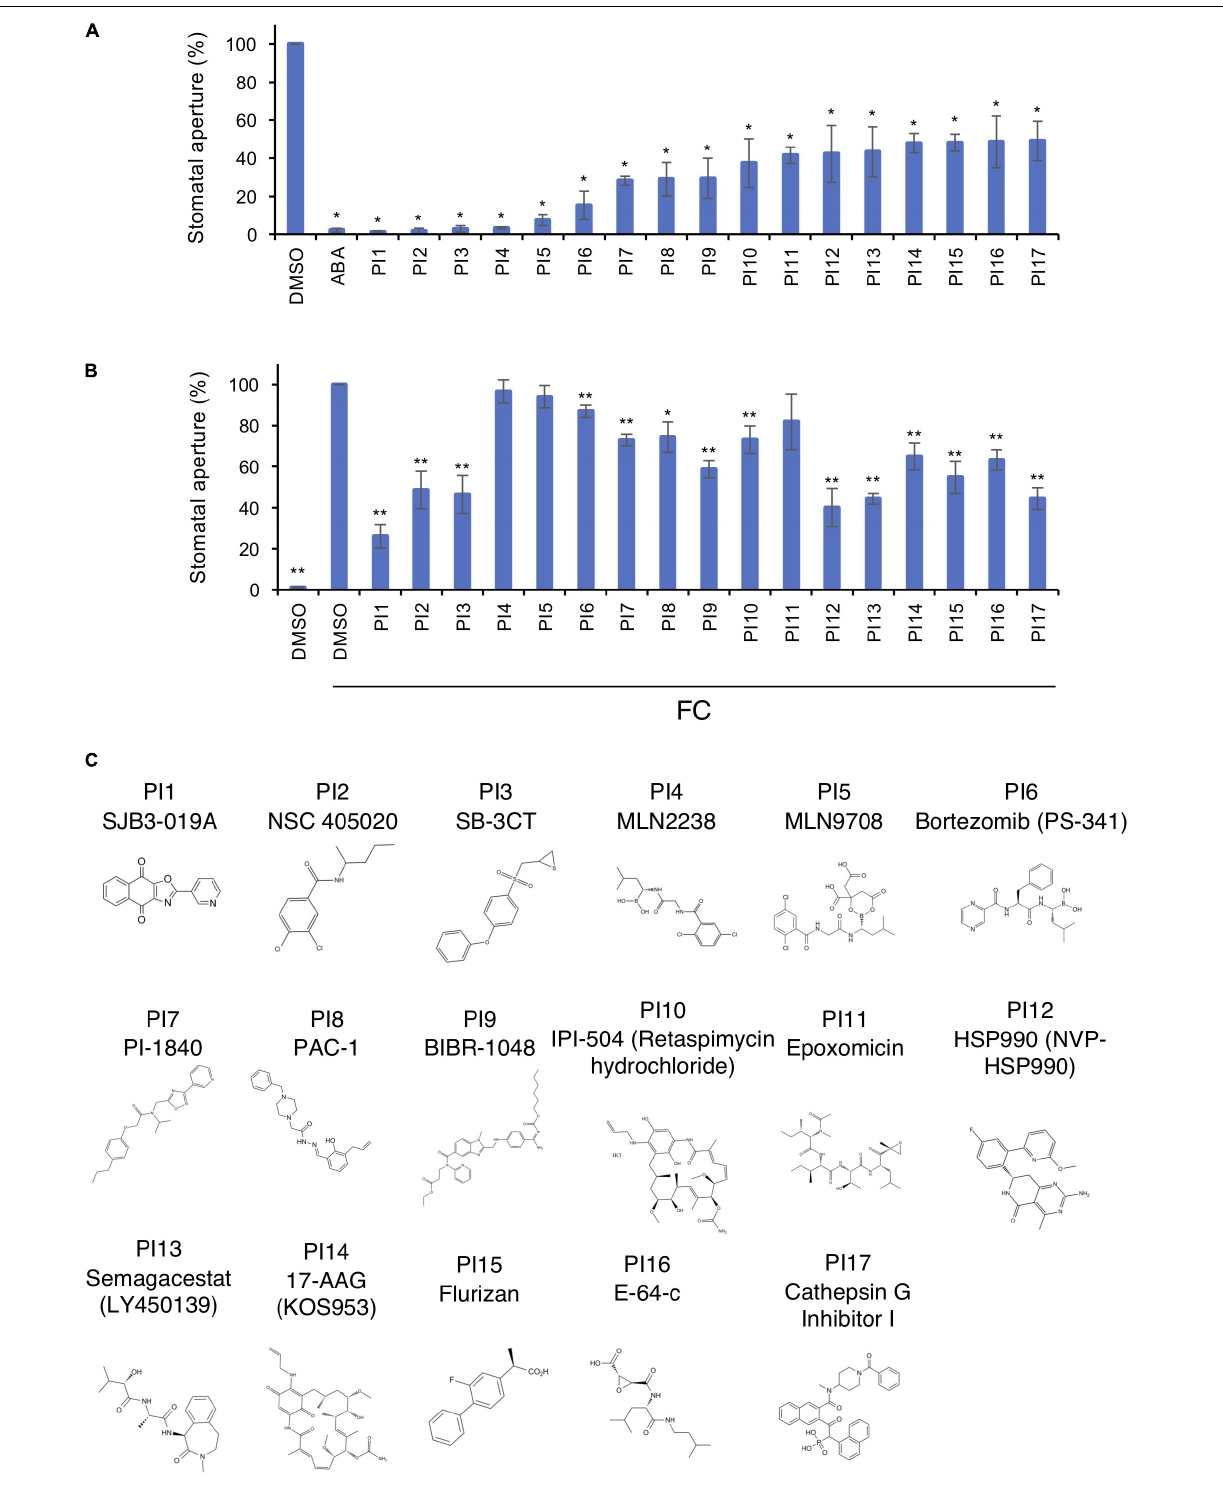
Frontiers in Plant Science |